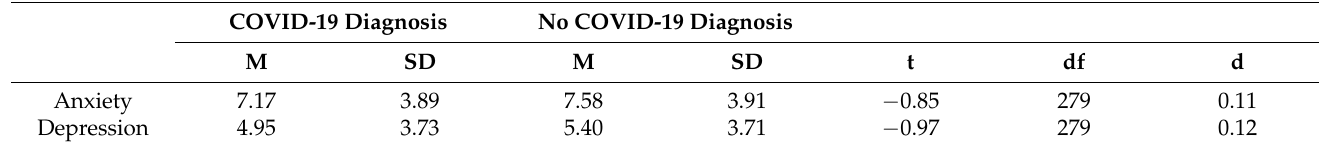
Table 13. Comparisons of the symptoms of anxiety and depression in participants with and without a previous COVID-19 diagnosis.